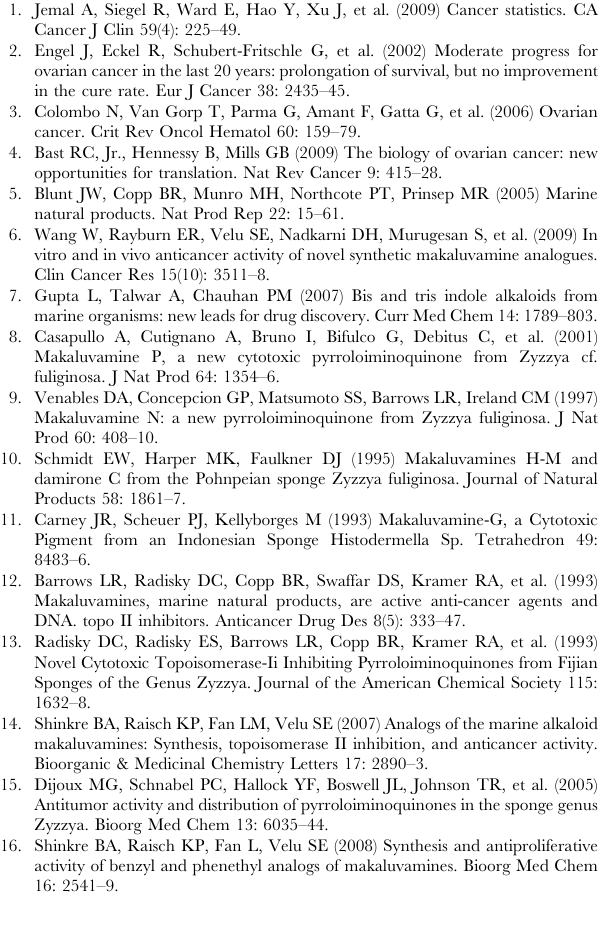
Table S1 Significant GOs up-regulated by FBA-TPQ. Table S2 Significant pathways up-regulated by FBA- TPQ.